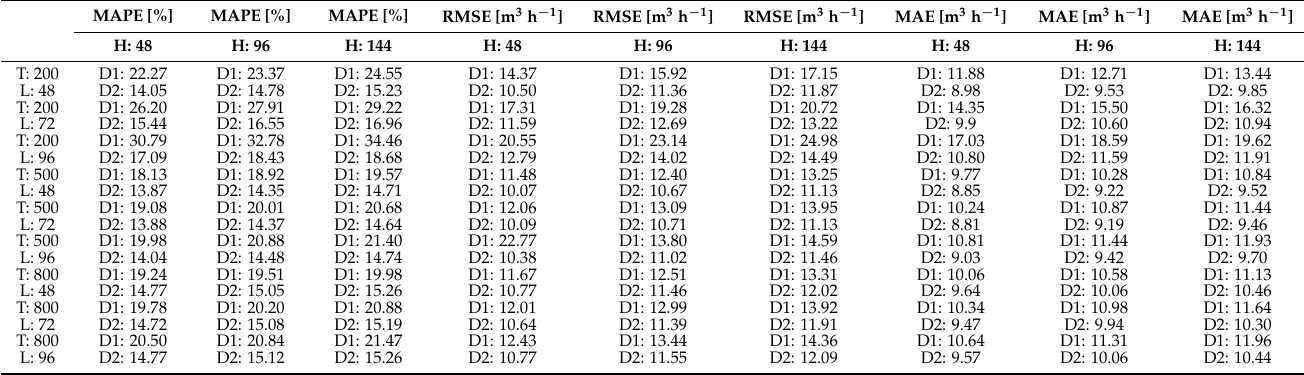
Table 1. Evaluation of model settings (H: horizon; T: training; L: lag) using the accuracy parameters MAPE [%], RMSE [m 3 h − 1 ], and MAE [m 3 h − 1 ] for the time series from digester one (D1) and digester two (D2). Each combination shows the mean value of 366 individual simulations.